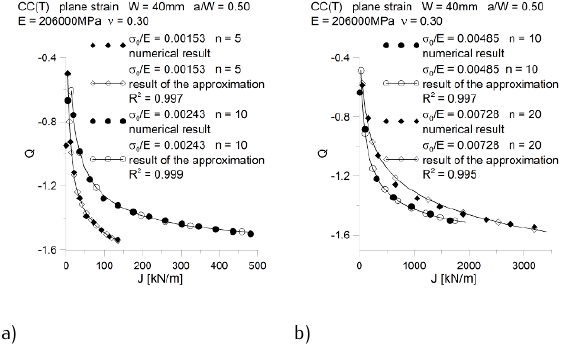
Figure 15. Comparison of the numerical results and their approx- imation for J - Q trajectories for CC(T) specimens: a) a / W =0.50; σ 0 ={315, 500}MPa; n ={5, 10}; b) a / W =0.50; σ 0 ={1000, 1500}MPa; n ={10, 20}.